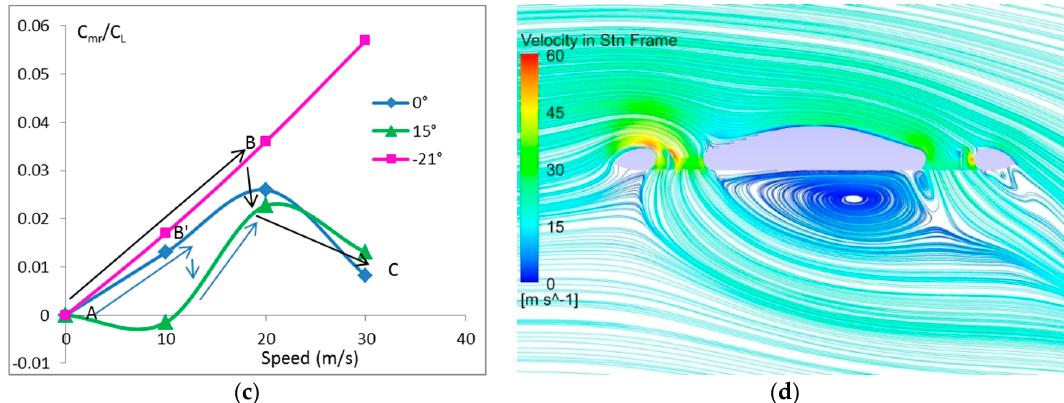
Figure 13. Computed time-averaged drag and moment coefficients to lift coefficient ratio at different angles of attack in transition mode. ( a ) Drag; ( b ) Pitching moment; ( c ) Rolling moment; ( d ) Surface streamlines in the central plane at the speed of 20 m/s.